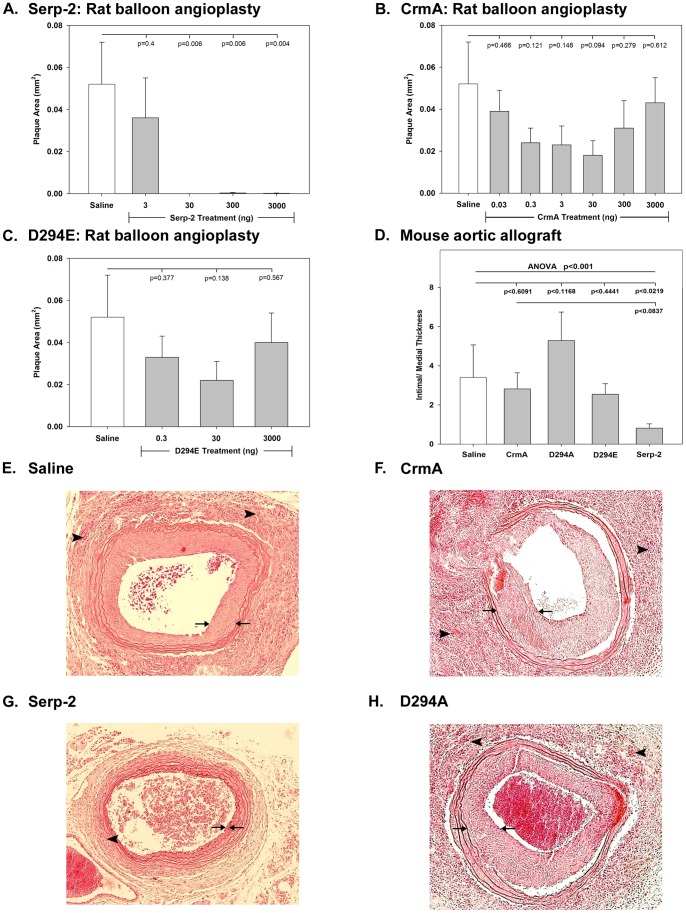
Serp-2 reduces plaque growth in arterial surgery models.Treatment of rat models of arterial injury with viral cross-class serpins demonstrates reduced vasculopathy. Haematoxylin and eosin stained sections of rat iliofemoral arterial sections harvested at 4 weeks and the mean plaque area were measured and presented as mean ± SE. The results demonstrated reduced plaque growth with Serp-2 (6 rats/dose; 3–3000 ng total N = 24) treatment at doses >30 ng (A). CrmA (6–12 rats/dose, 0.03–3000 ng; total N = 60) (B) and the Serp-2 reactive center loop mutant D294E (6 rats/dose, 0.3–3000 ng; total N = 18) treatments (C) demonstrated a non-significant trend toward reduced plaque at 30 ng, with no significant inhibition of plaque growth at higher concentrations. (D) In the mouse aortic allograft transplant model (PAI-1−/−, B6.129S2-Serpine1tm1Mlg donor to Balb/C recipient) Serp-2 again significantly reduced plaque (p<0.026), whereas CrmA and the D294A and D294E Serp-2 RCL mutants did not reduce plaque (total mice 33). (E–H) Five micron thick cross sections of mouse aortic allograft transplants taken from within the transplanted donor aortic section, demonstrate the marked intimal hyperplasia and associated mononuclear cell invasion in the adventitial layers in saline (E) or CrmA (F) treated mice. Treatment with Serp-2 (G) but not Serp-2 D294E mutants (H), displayed reduced plaque and inflammation. Arrows bracket intimal plaque limits. Arrowheads point to areas of mononuclear cell invasion. Magnification 100X.